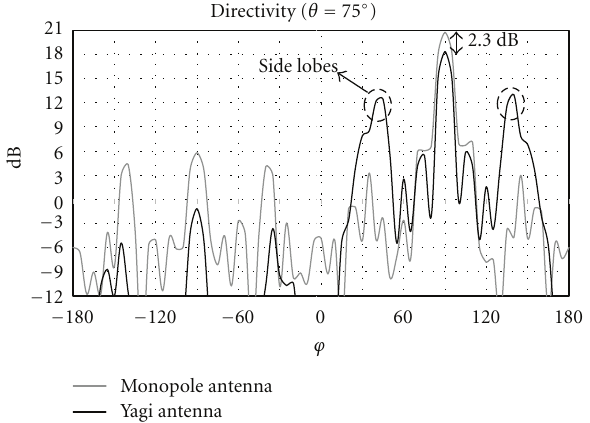
Figure 23: Comparison of the radiation pattern of 4 × 12 monop- oles with the 4 × Yagi array